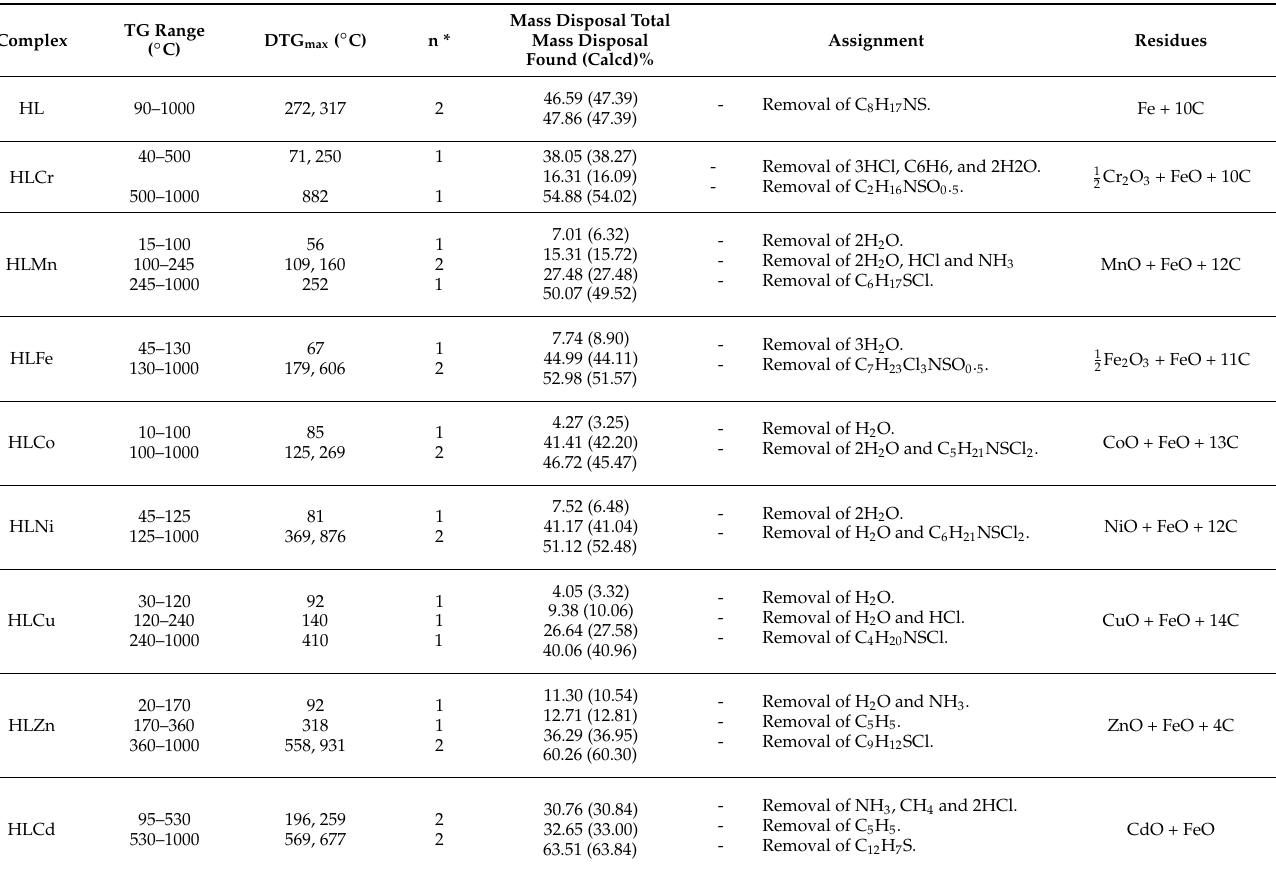
Table 5. Thermoanalytical results (DTG/TG) of the organometallic acetyl ferrocene imine ligand and its metal